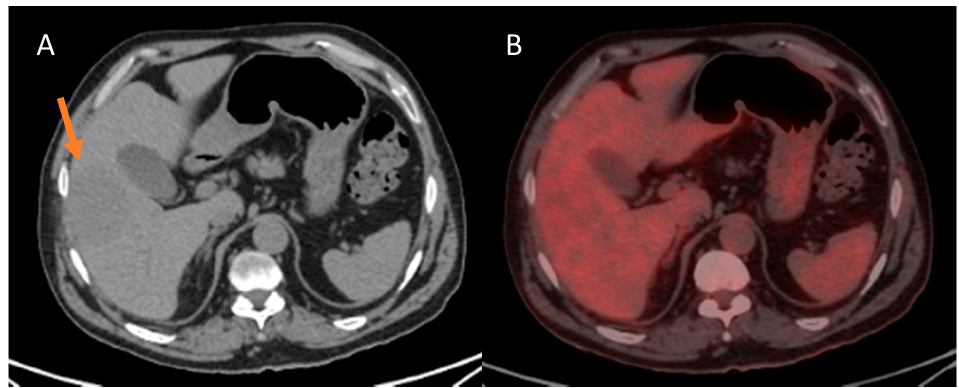
Figure 2. Patient without liver disease who developed a hepatocellular carcinoma (HCC) of 65 mm on CT (( A ), orange arrow) showing a similar FDG uptake as the rest of the liver parenchyma ( B ) with SULpeak60 of 2.0 and TLRpeak60 of 1.02. At the pathology analysis, a grade 2 HCC with microvascular invasion (MVI) was confirmed. No disease recurrence was evidenced after a follow-up of nine